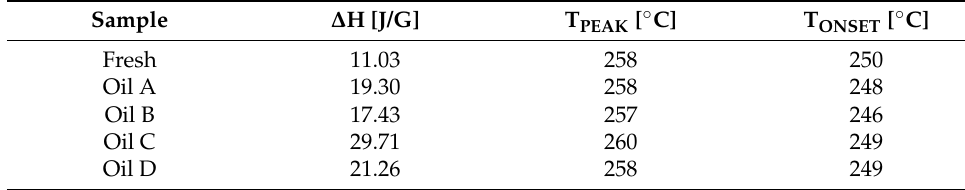
Table 7. DSC results for the PA66 samples (fresh and aged in the ATFs).